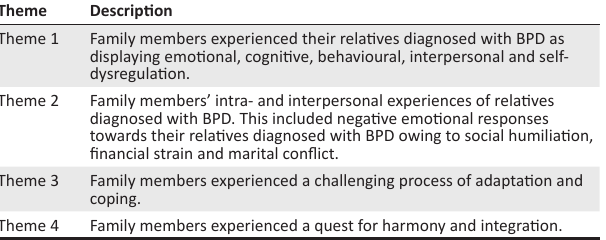
TABLE 2: Family members’ experiences of a relative diagnosed with borderline personality disorder.